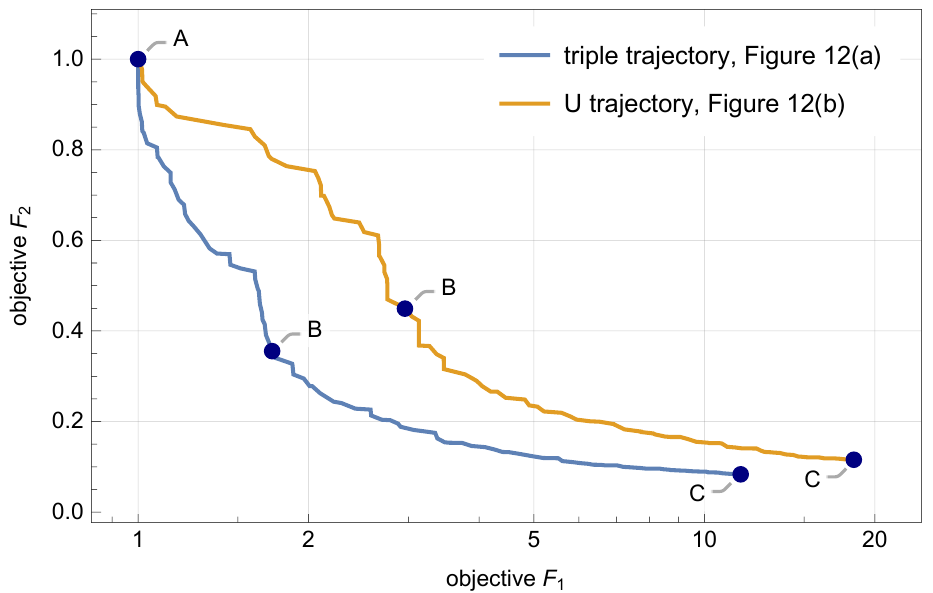
Figure 13. The final Pareto fronts obtained from NSGA-II for the two compound trajectories shown in Figure 12. Three specific points on each front are labeled “A”, “B”, and “C”, and the corresponding identified trajectories are shown in Figures 14 and 15.